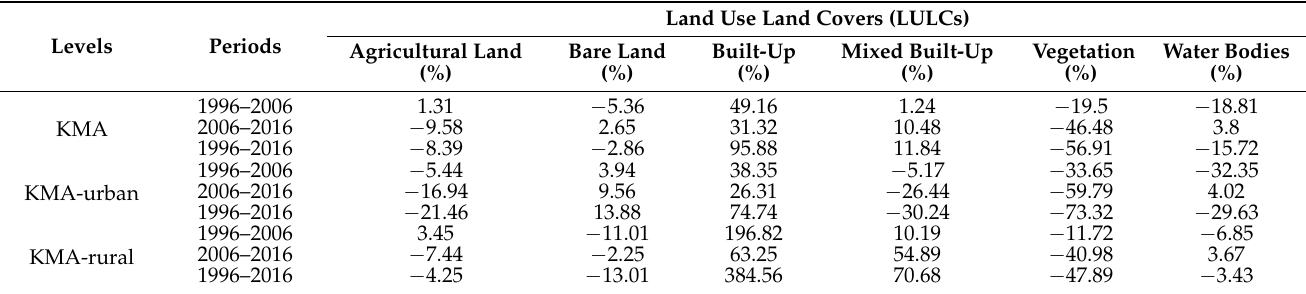
Table 2. Decadal growth (%) in the LULCs over KMA, KMA-urban, and KMA-rural during 1996–2006, 2006–2016, and 1996–2016. Levels Periods